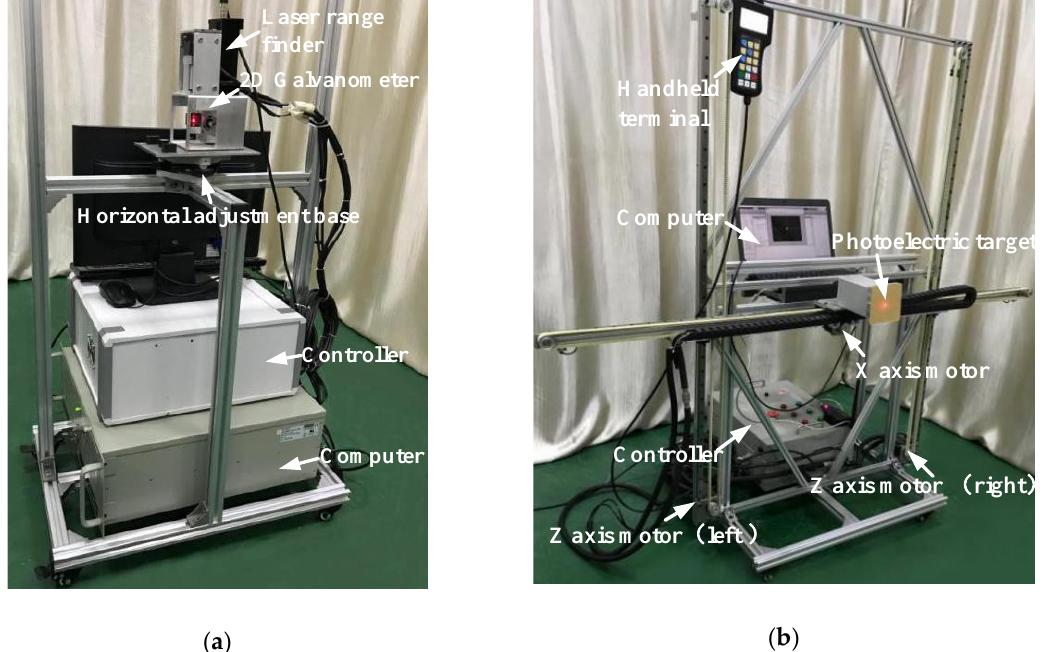
Figure 4. Experimental setup of galvanometer calibration ( a ) 2D galvanometer system; ( b ) 2D moving